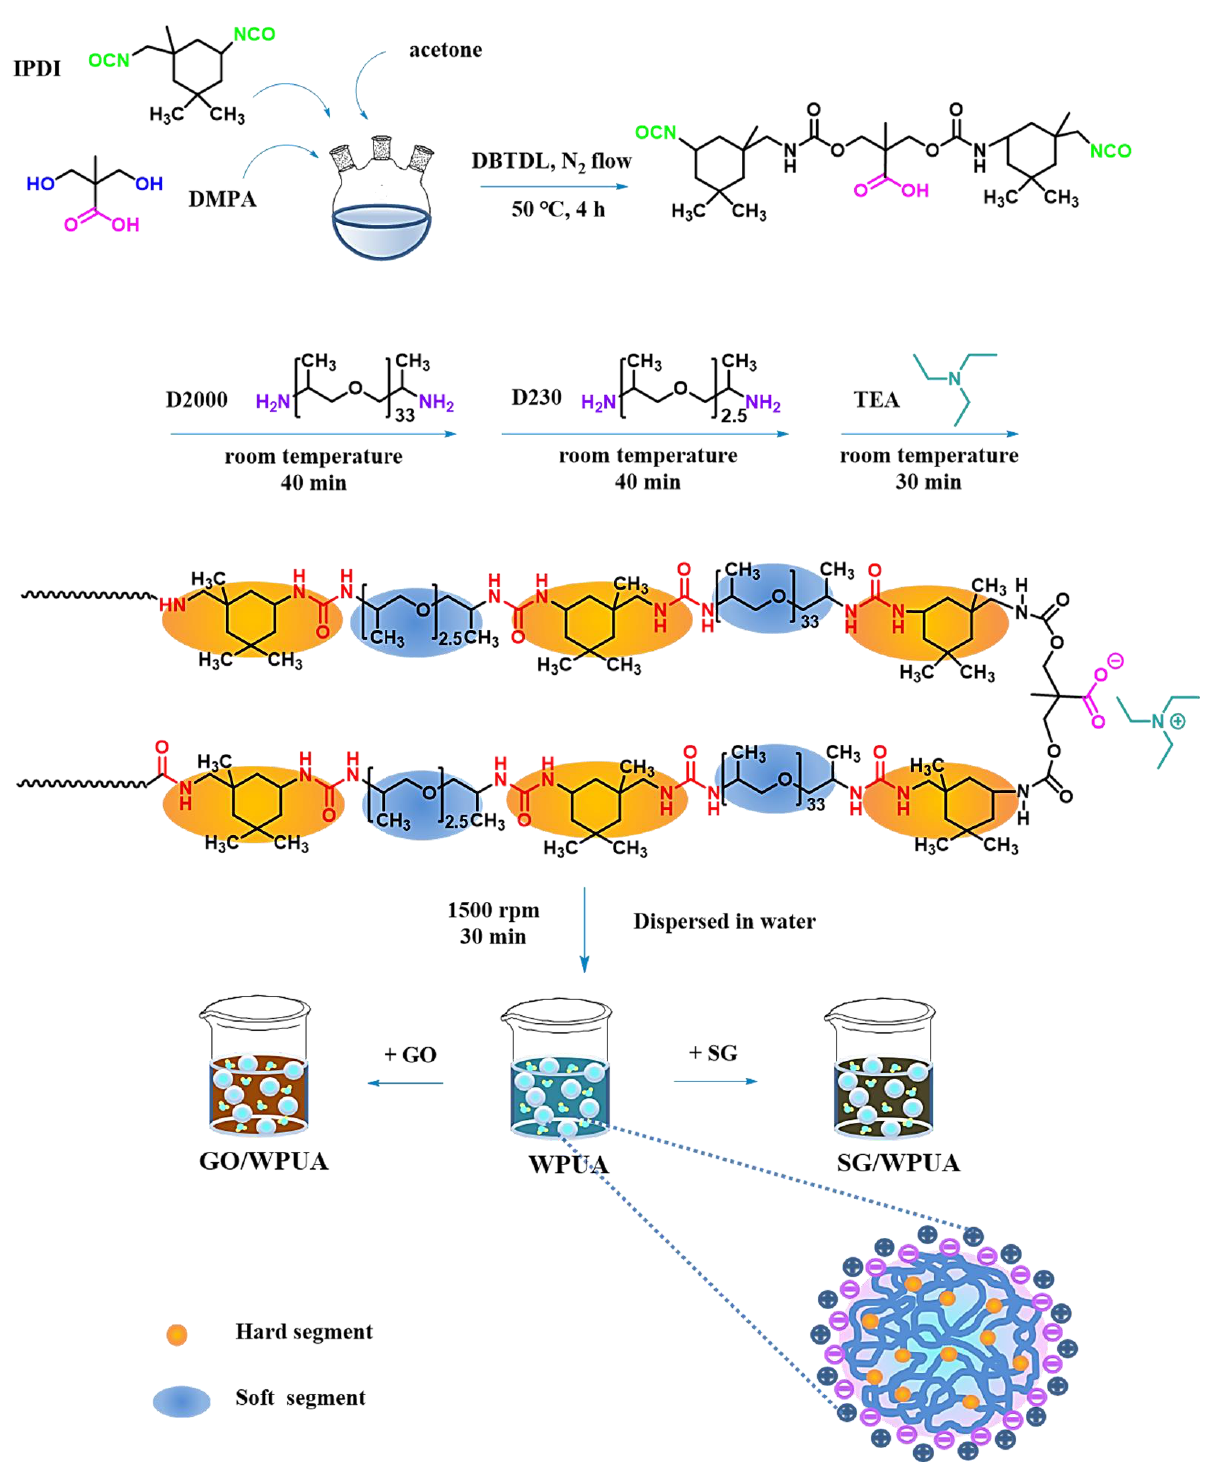
Figure 2. Reaction scheme to synthesize waterborne polyurea (WPUA), GO/WPUA, and SG/WPUA coatings.